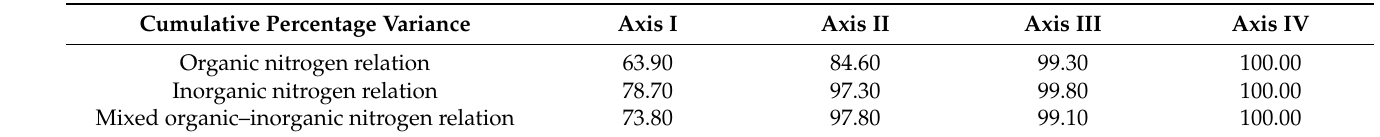
Table 2. Redundancy analysis of eigenvalues for the fine-root–soil stoichiometry of Picea schrenkiana at different root sequences under the level of the mixed organic–inorganic nitrogen source.